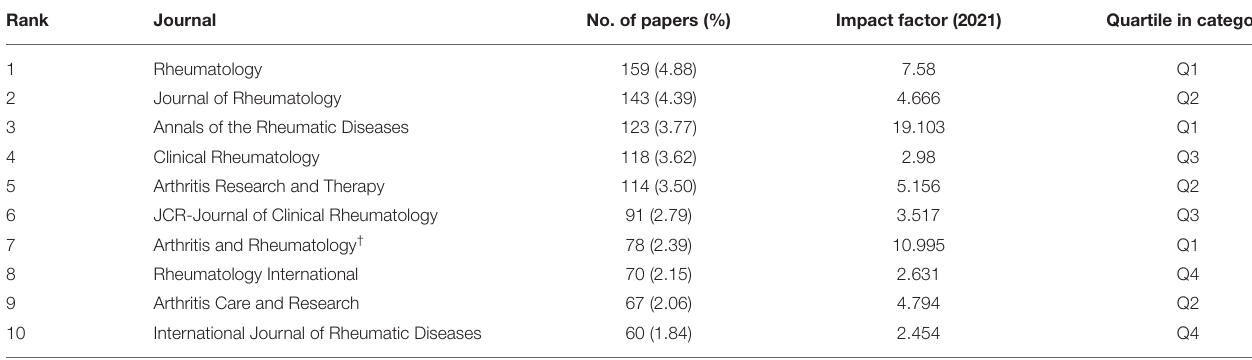
TABLE 2 | The top 10 journals contributing to